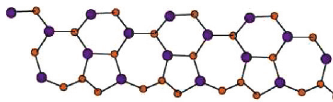
C I [ p,q ] for p � 4, q � 3. 2 3